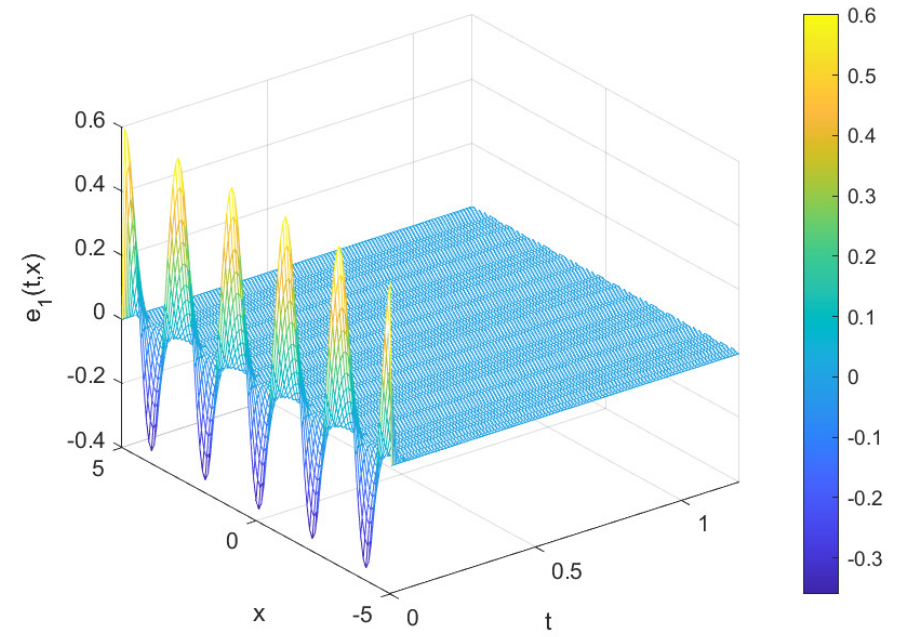
Figure 4. Time evaluation of synchronization error of e 1 ( t , x ) .